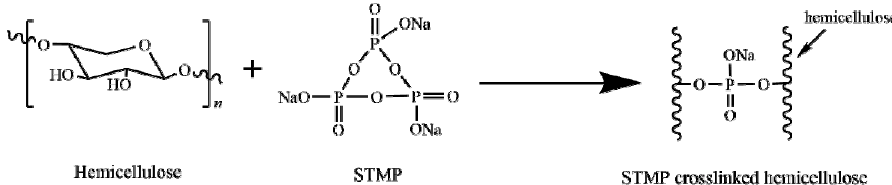
Figure 2. Crosslinking reaction of hemicellulose with sodium trimetaphosphate